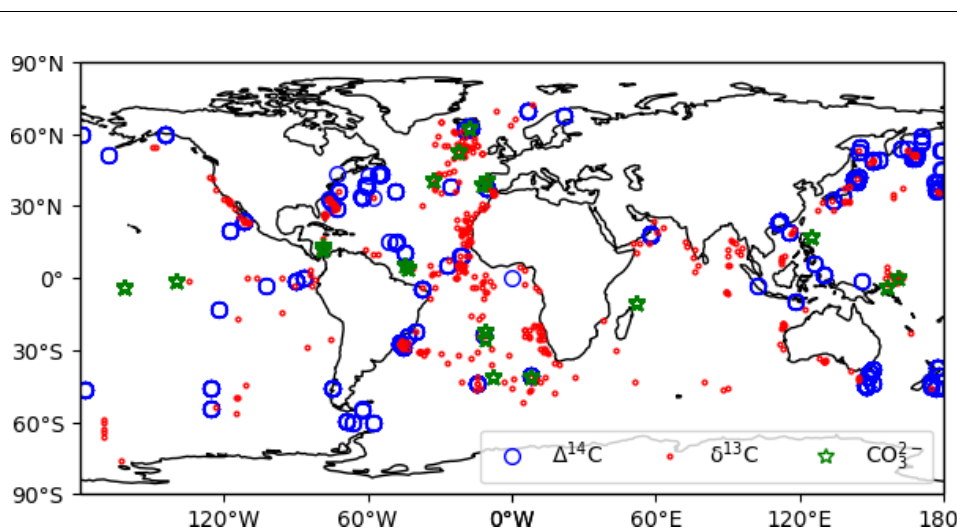
− data locations. (cid:49) 14 C and CO 2 − data are compiled from published estimates. For δ 13 C we take the Figure 3. (cid:49) 14 C, δ 13 C and CO 2 3 3 compilation of Oliver et al. (2010). MIS and model box-averaged data and their respective standard deviations are shown in Tables